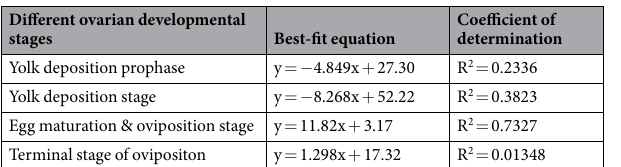
between virgin and mated OFM females. The corpus bursa of virgin females was flat with no spermatophore inside. The accessory sac of the corpus bursa was transparent to translucent, and its contents were thin and trans- parent (Fig. 8A). The shape of the corpus bursa changed (having a spherical protrusion in the center) immediately after effective mating; there was a white to deep yellow spermatophore in the center of the corpus bursa, while the accessory sac of the corpus bursa remained transparent and did not undergo an obvious change (Fig. 8B). The shape of the corpus bursa did not change obviously 6 hours after mating, but the spermatophore became